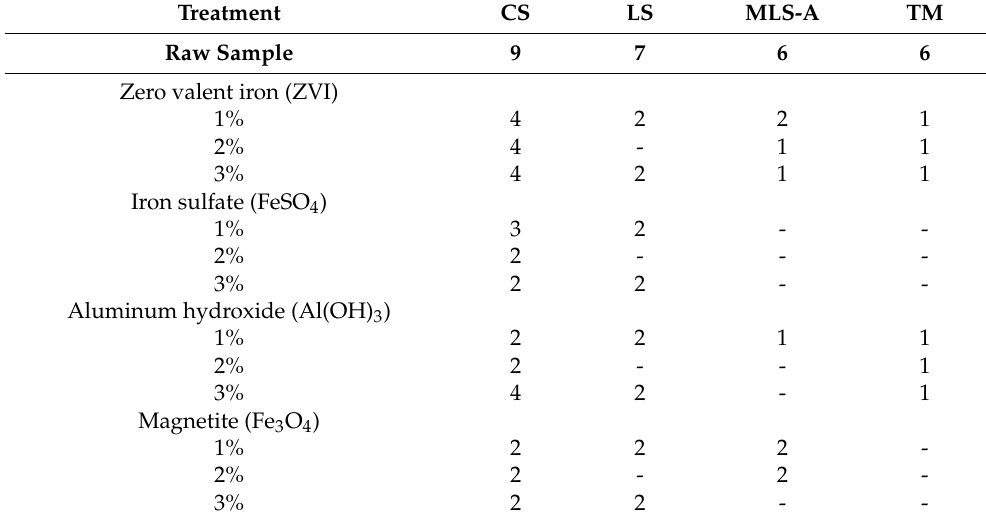
Table 2. Summary of the treatment (stabilizing agent + dosage) tested for each excavated material. For each case, the number of replicates used is indicated. When a dash is mentioned, the corresponding treatment has not been